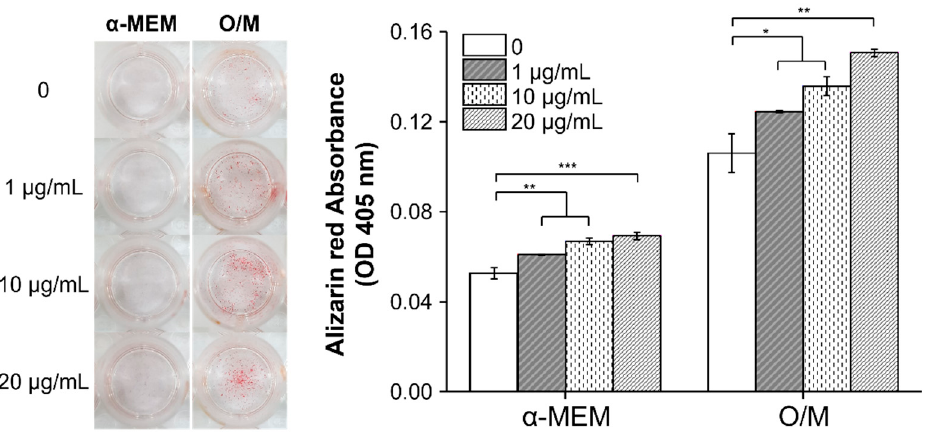
Figure 5. Alizarin red staining (ARS) showing the mineralization of cells cultured in normal and osteogenic media (* p < 0.05, ** p < 0.01 and *** p < 0.001). osteogenic media (* p < 0.05, ** p < 0.01 and *** p <